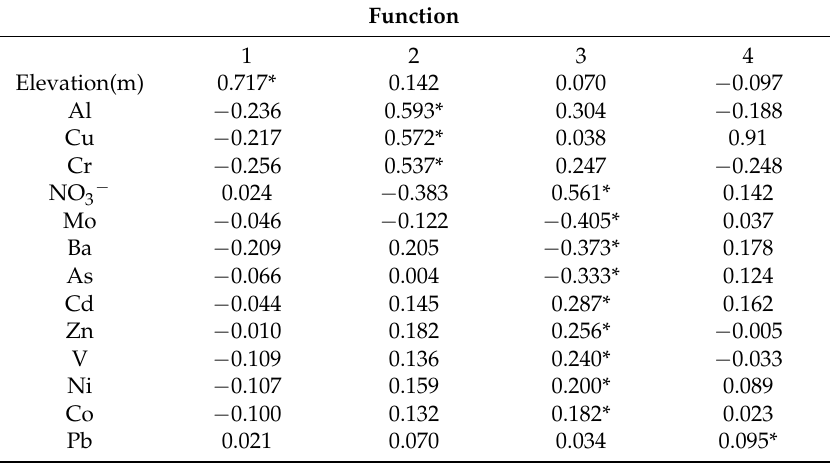
Table 7. Structure matrix showing influence of each chemical parameter on site separation.